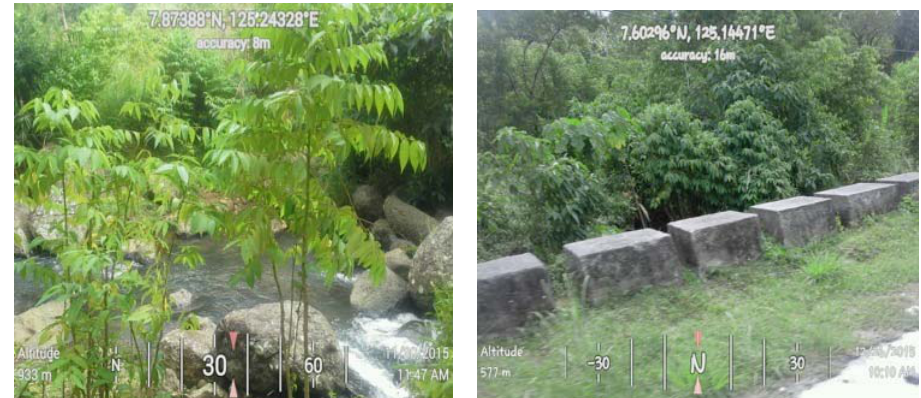
Fig. 2: An image showing Piper aduncum L. in Quezon, Bukidnon